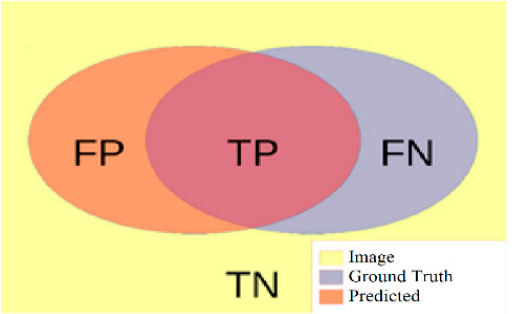
Clockwise Rotation Figure 4. Outputs of images obtained by data augmentation method. 4.3. Post-Processing While any image is predicted or tested by the model, each pixel of the image is inde- pendently classified as liver or background. The image value obtained as a result of the estimation is sent to a generated threshold function. The function examines the value of each pixel individually. If the pixel value is greater than 0.5, that pixel is considered a liver and assigns 1 to that pixel’s value. If the pixel value is less than 0.5, it considers this pixel as the background and assigns the value 0. This process is similarly applied to the tumor image. If a 3-dimensional view is to be obtained from all images of the patient, after the above steps are applied to all slices of the patient, these slices are combined and mesh (Laplacian smoot, Faces orientation) operations are applied. The 3D image of a patient we obtained is in last figure. 4.4. Metrics